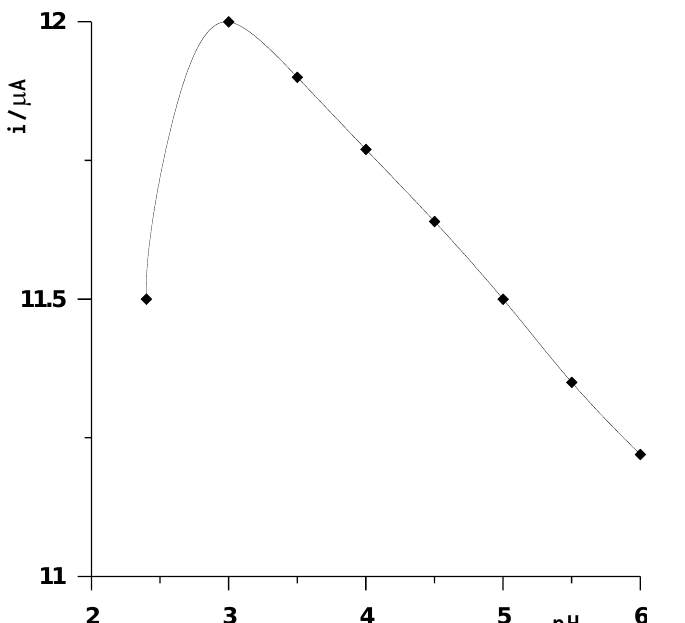
Figure 2. The influence of pH on the voltammetric signal of 5 × 10 −8 mol L −1 Cd(II). In the case of pH = 2.4, acetic acid was used, in the case of other pHs, acetate buffer was used. Bi(III) ions, from which a film of bismuth was formed during the measurement as a result of its reduction to metallic form, were another component of the solution in measurements based on in-situ formed BiFEs. Therefore, the behavior of the cadmium signal as a function of Bi(III) concentration was investigated. It was observed that with increasing concentration of bismuth ions in the solution, the cadmium peak gradually increased until a concentration of 0.15 mmol L − 1 , at which point it reached a maximum value. This concentration was taken as the optimal value because the cadmium peak began to gradually decrease for Bi(III) concentrations above 2 mmol L − 1 . Measurements made to select the optimal concentration of bismuth were carried out in a solution of 0.1 mol L − 1 acetate buffer containing 5 × 10 − 8 mol L − 1 Cd(II), and the results are shown in Figure